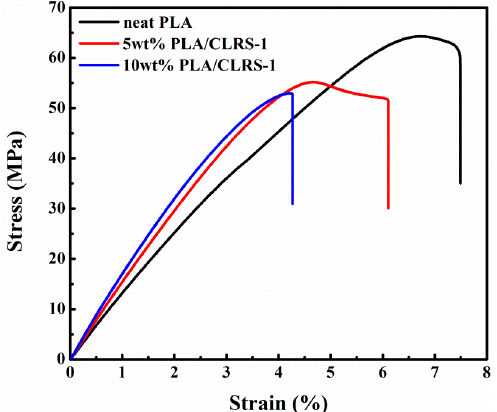
Figure 1. Typical tensile stress–strain curves of 3D printed neat polylactide (PLA) and polylactide/lunar regolith simulant (PLA/CLRS-1) samples for different contents.